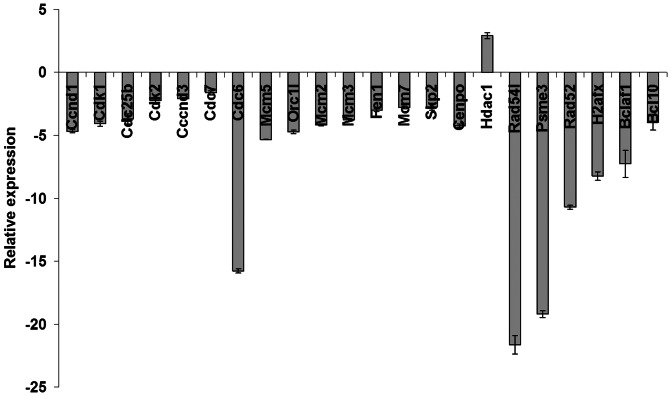
Validation of miR-7 targets.Genes involved in cell cycle regulation and DNA repair were validated by qRT-PCR. Relative expression was calculated using the 2−ΔΔCt method with β-actin used as an endogenous control.